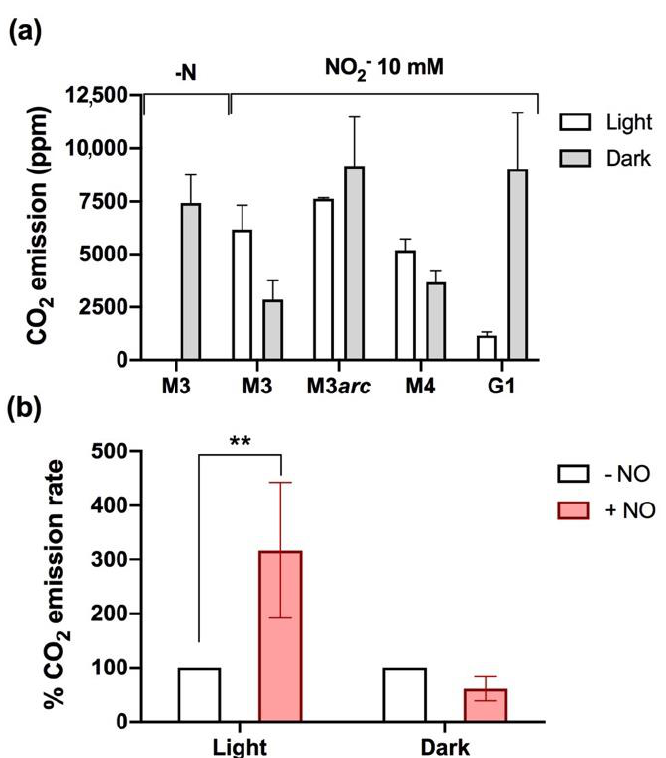
Figure 4. NR impacts CO 2 evolution in the nii1 mutants. ( a ) CO 2 emission by the nii1 mutants under light and dark incubation in 10 mM NO 2 − and N-free media after 24 h. ( b ) CO 2 emission rates after adding 40 µ M DEA-NONOate to G1 cultures in light and dark conditions. The initial rates (100%) correspond to 44.28 ppm/h and 78.21 ppm/h in light and dark, respectively. Error bars represent ± SD, n ≥ 3. Student’s t test was performed. ** p ≤ 0.001.